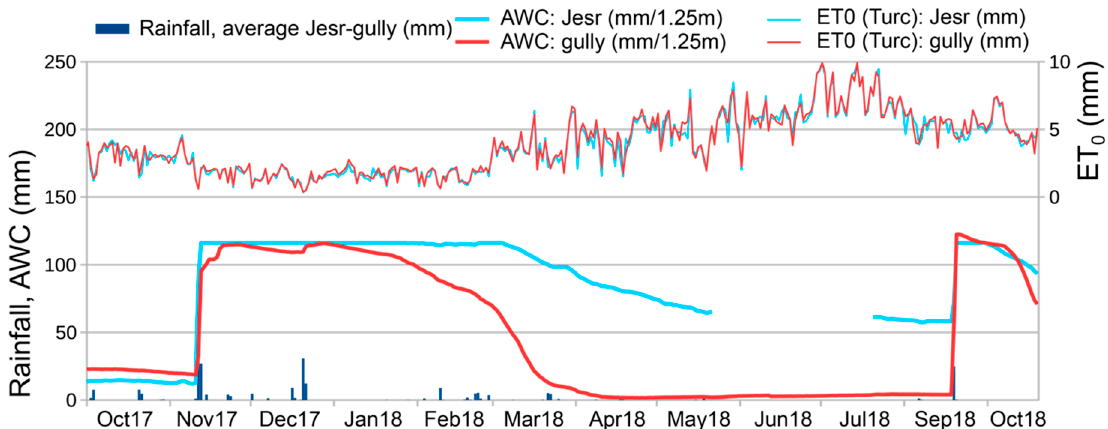
Figure 9. Evolution of available water capacity (AWC) and potential evapotranspiration (ET 0 ) in the Jesr and the gully.